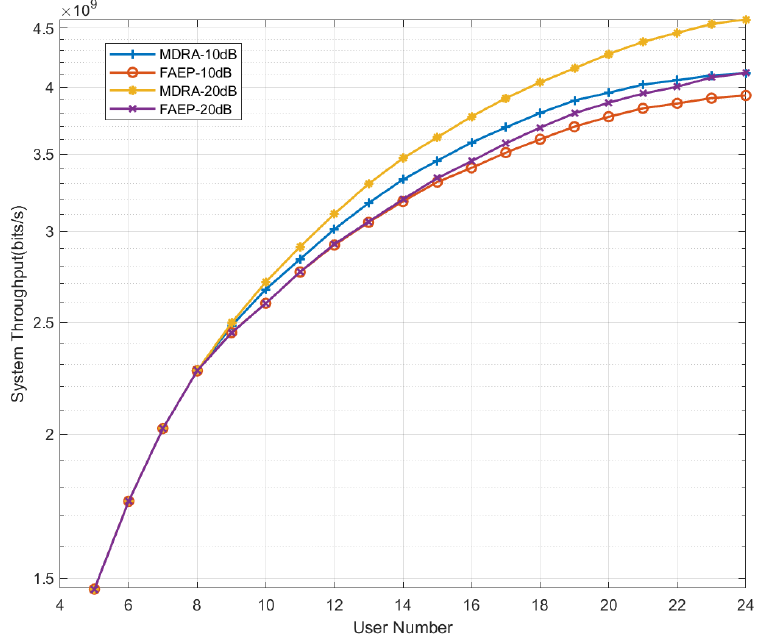
Figure 8. The performance of Algorithm 2 with different power constraint of